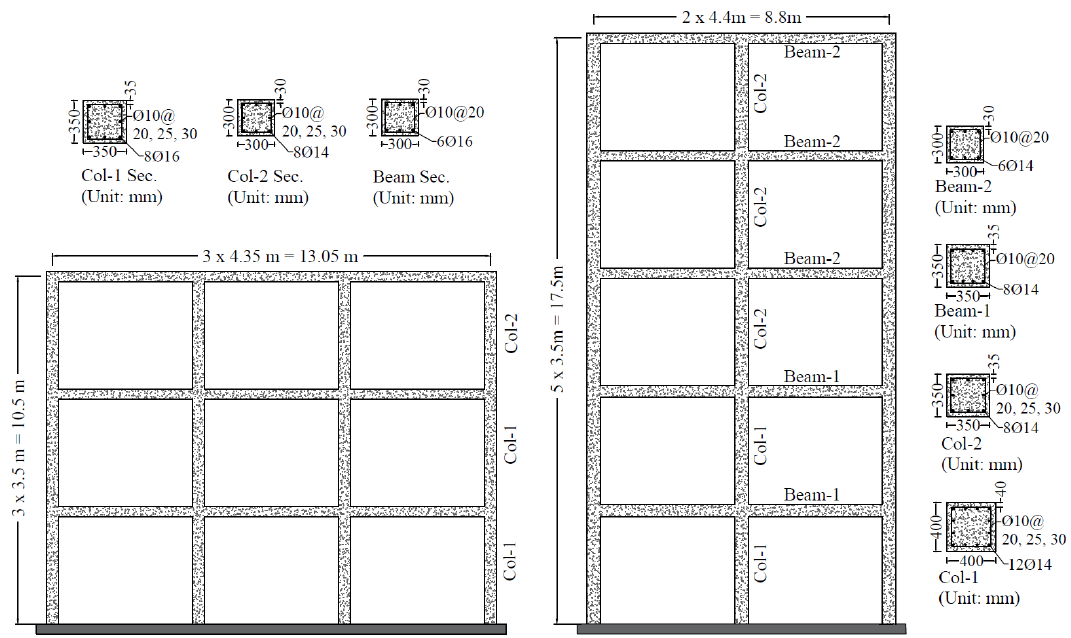
Fig. 4. Elevation view and structural details of case study